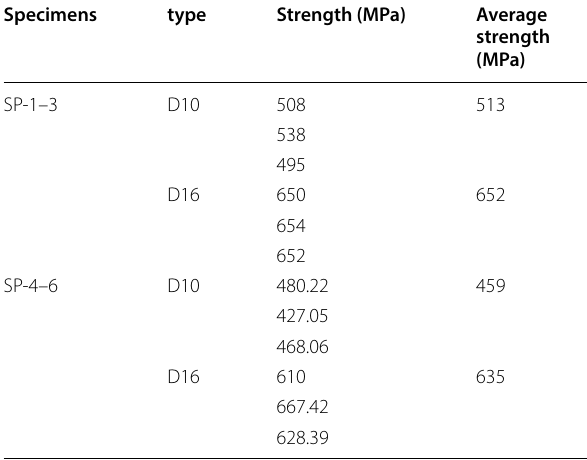
Table 3 Rebar tensile strength test.